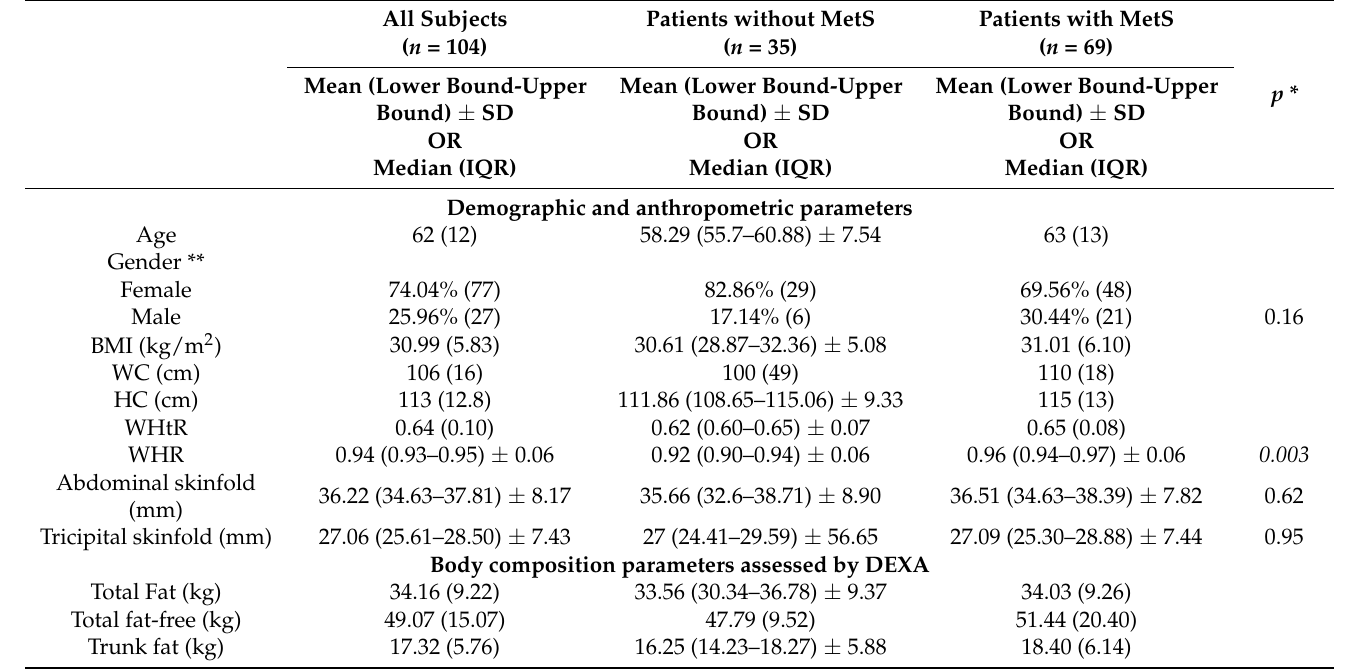
Table 1. Baseline characteristics of the study